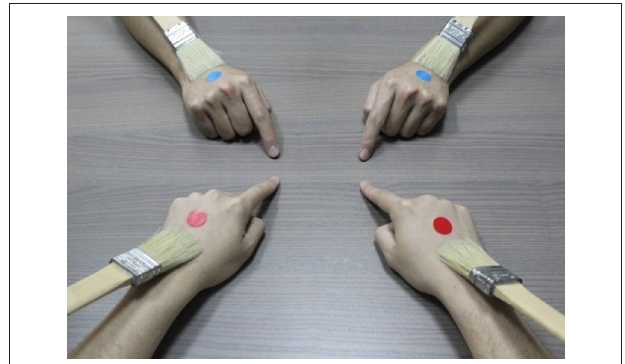
FIGURE 1 | The set-up of the four-hand illusion. In Experiments 3, the experimenter’s hands were seen via the HMD from the adopted 1PP with red tags, and the participant’s own hands were seen via the HMD from the adopted 3PP (180 ◦ reverse) with blue tags. Both the participant and the experimenter tapped their index fingers and received tactile stimulations. To measure SCR, two single-use foam electrodes were attached to the inner side of the participant’s left palm. The wires were carefully put under the participant’s arm. So both the electrodes and the wires would not be seen by the participant via the HMD. This figure and its descriptions are adopted from Chen et al. (2018).